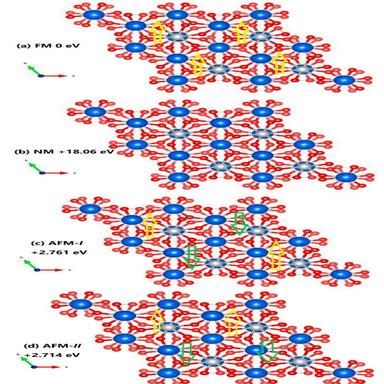
Total energies of the FM, NM, AFM-I and AFM-II states of rhombohedral R3c-type HoNiO3 with a 2 � 2 � 1 superlattice.